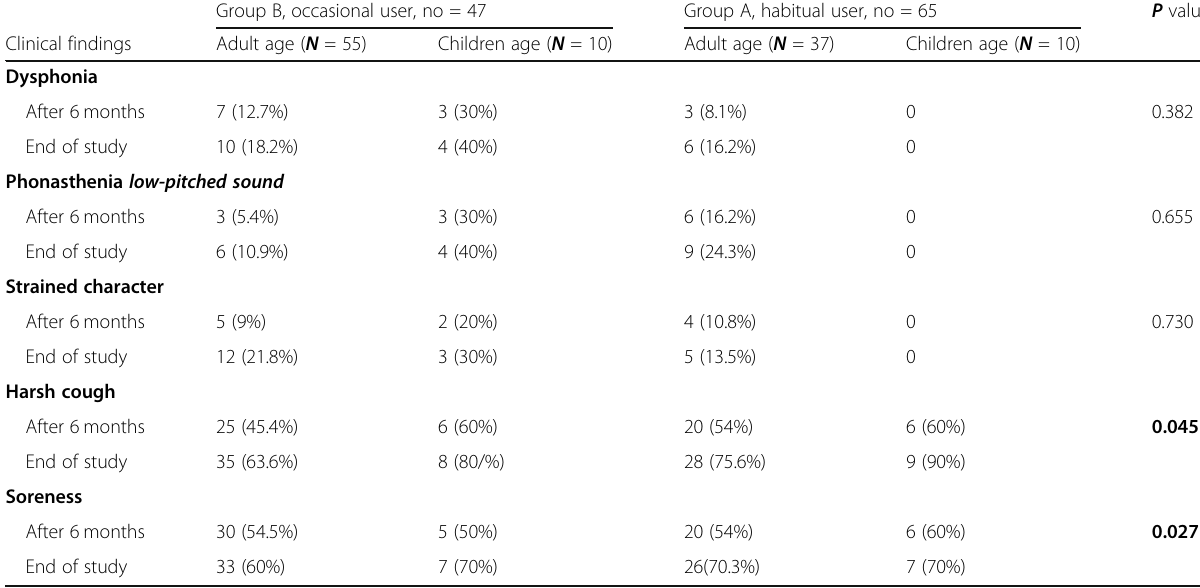
Table 2 Clinical and vocal phonetic findings in studied cases Group B, occasional user, no = 47 Group A, habitual user, no =